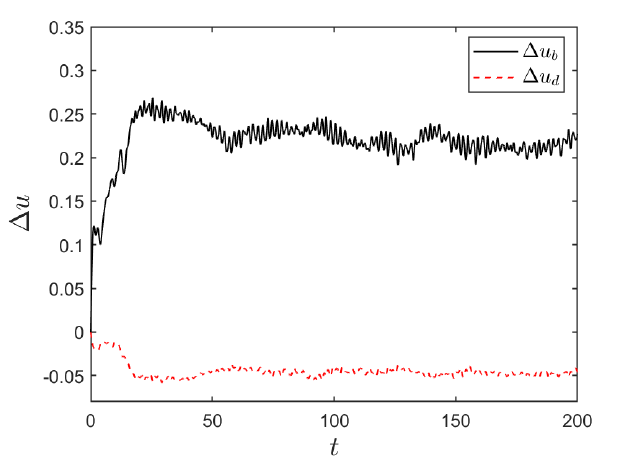
Figure 2. The slip velocity versus time for Eo b = 2 and N d =